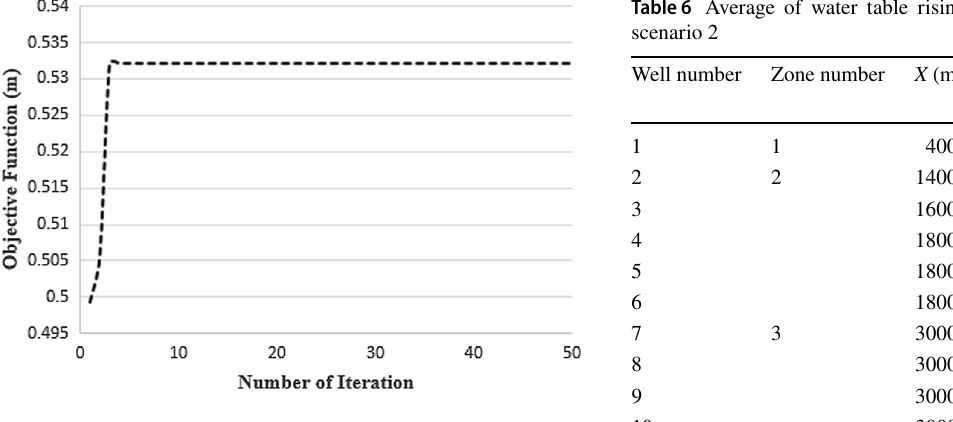
Fig. 8 The convergence process of simulation–optimization model IGA-GWO under scenario 2